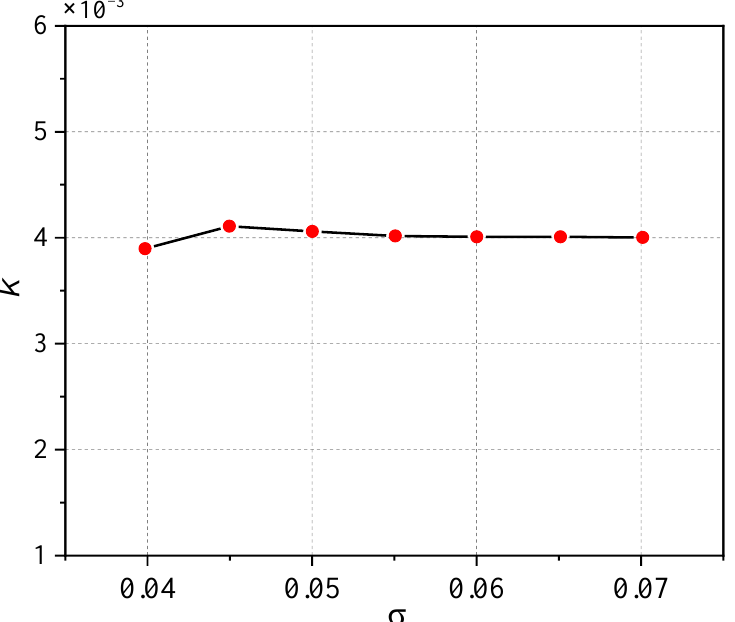
Figure 11. Relation between the slope of the line and the surface tension, where the surface tensions are different.